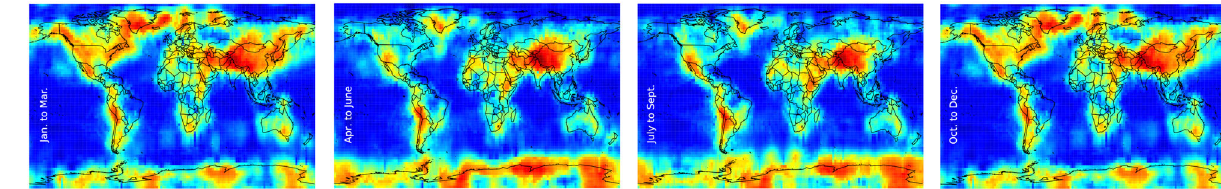
Fig. 1 | Spatial patterns of diffusion-capacity values that correspond to average values of trimestral networks. Colors of geographical points correspond to the diffusion-capacity mean value of each season computed through daily surface air temperature